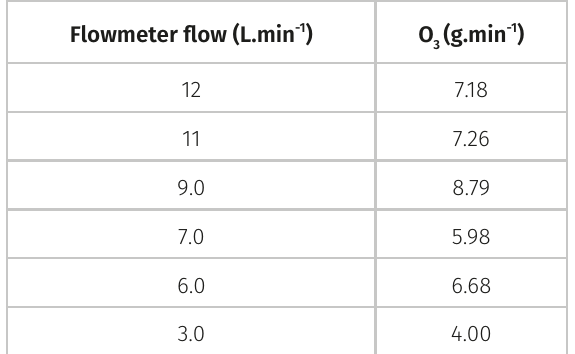
Table II. Determination of the O by the ozonator according to the compressor air flow